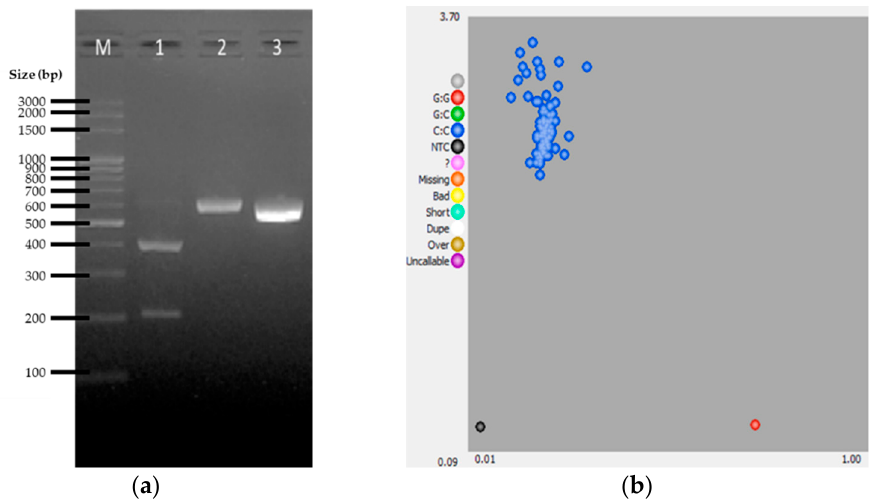
Figure 2. Representative results for MTCYB gene SNP genotyping by PCR-RFLP and KASP assays. ( a ) Agarose gel electrophoretic profile of selected samples showing the banding patterns for the MTCYB G allele (lane 1), and MTCYB C allele (lane 2), and the undigested PCR amplicon (lane 3). ( b ) Cluster plot for the KASP genotyping assay: MTCYB G allele (red cluster), and MTCYB C allele (blue cluster).